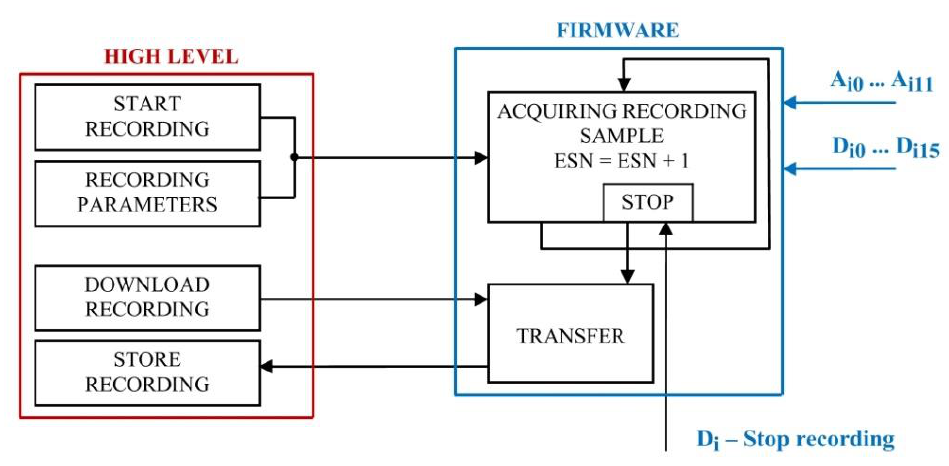
Figure 11. High-level/Low-level communication flow for triggering recordings.